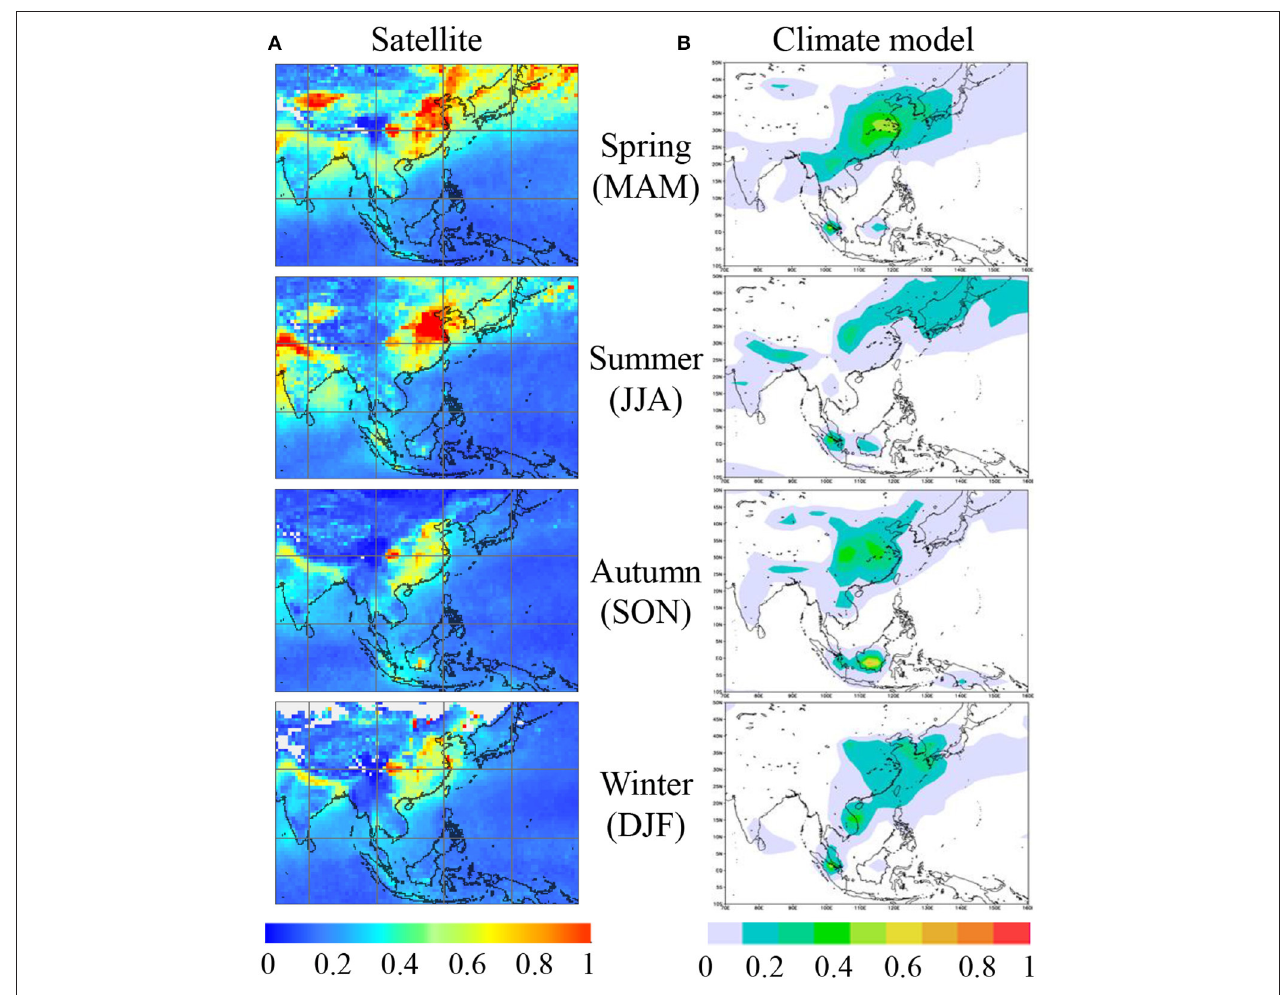
FIGURE 1 | Seasonally averaged AOT (0.55 µ m) in 2003 from climate model simulations and NASA/Terra/MODIS (MOD08_M3 Collection 6). The MODIS products in this image are cited according to the citation rules of NASA. No further permission is required for the image reproduction.